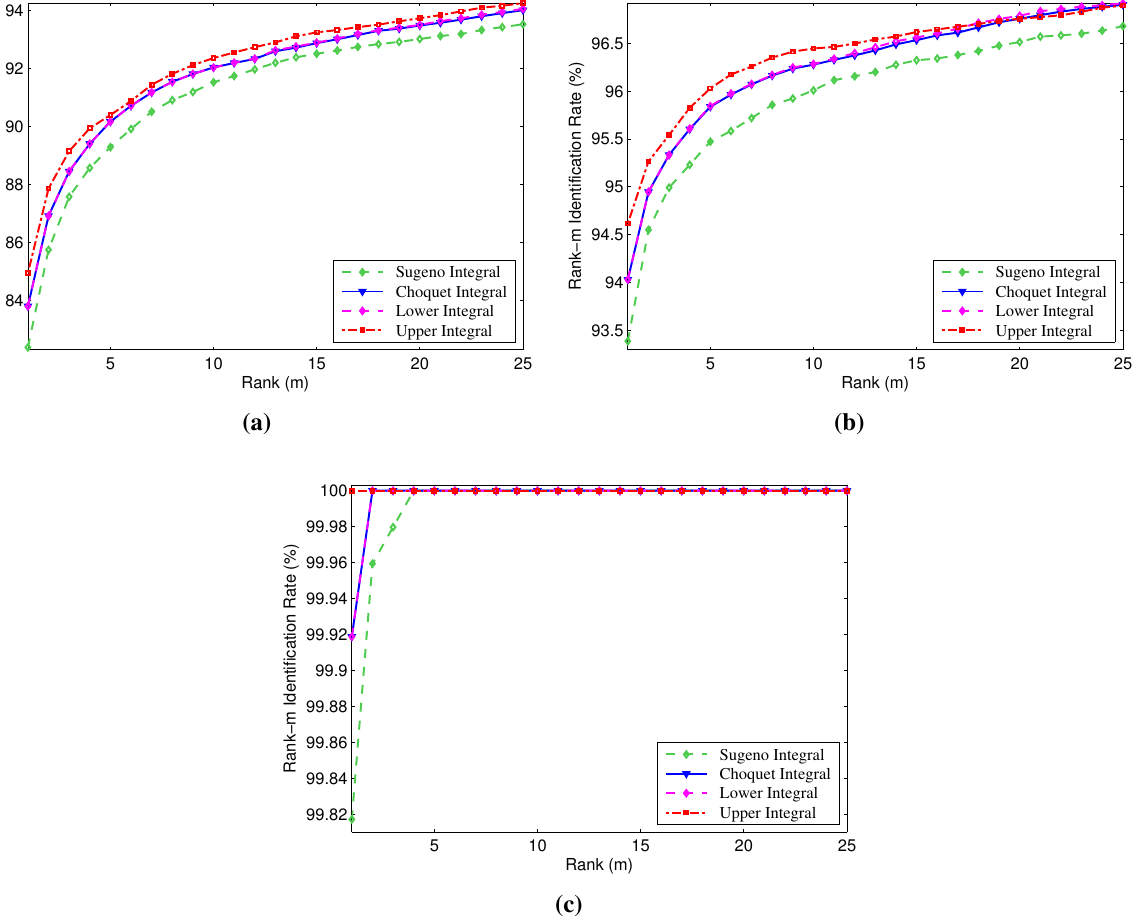
Figure 2. Cumulative match characteristic curves of the proposed method and other fuzzy integrals on the ( a ) NIST-Face, ( b ) NIST-Fingerprint and ( c ) NIST-Multimodal